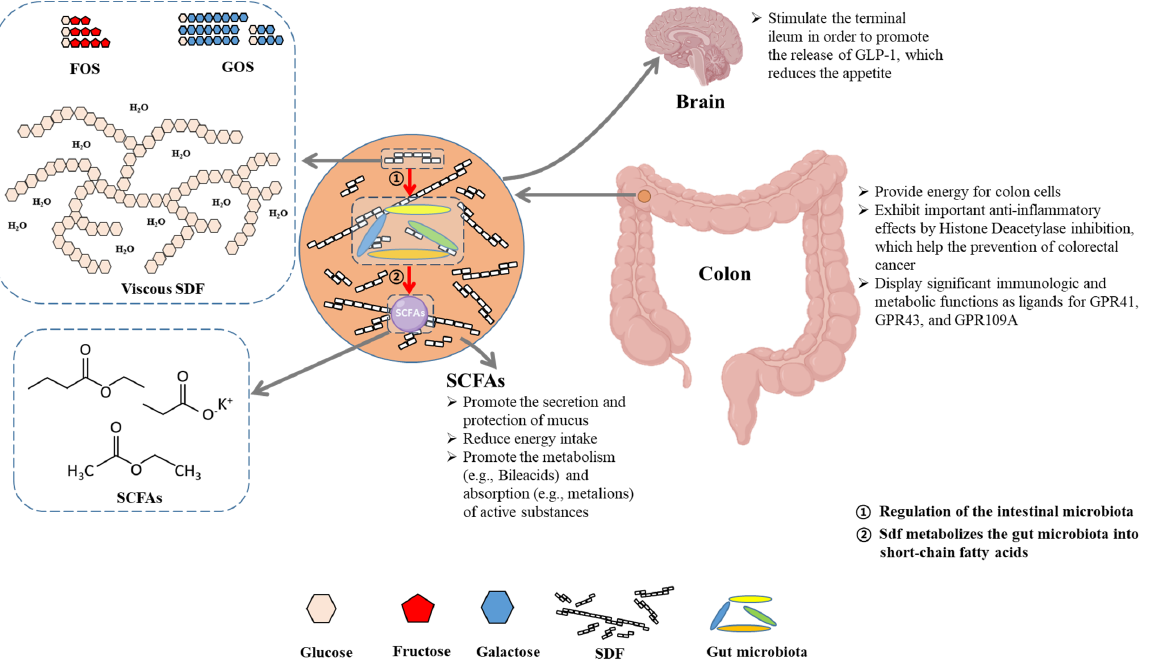
Figure 5. Summary of identified physiological effects of SDF and SCFAs on human health. Adapted from